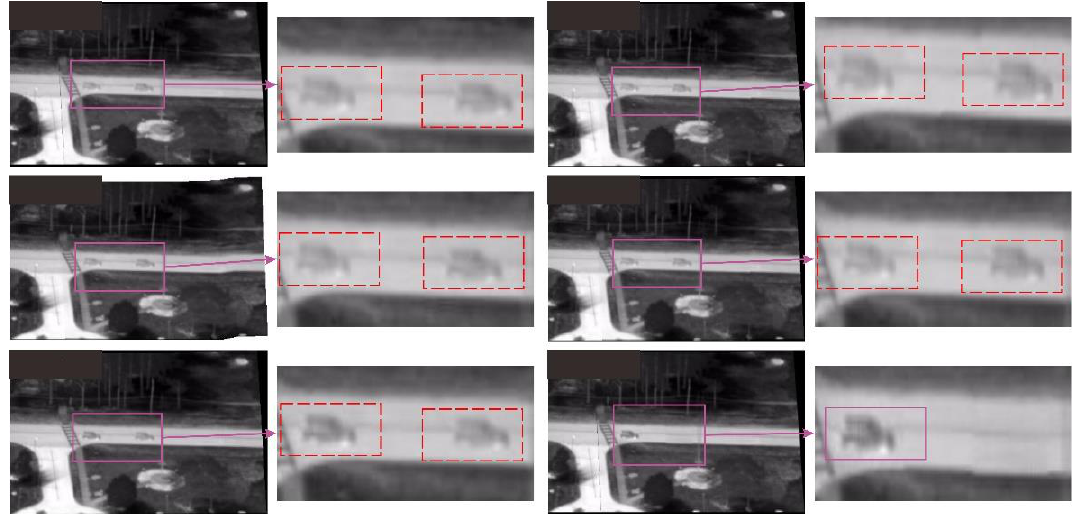
Figure 15. Comparison between the proposed method and SOTA methods on pk01 data.